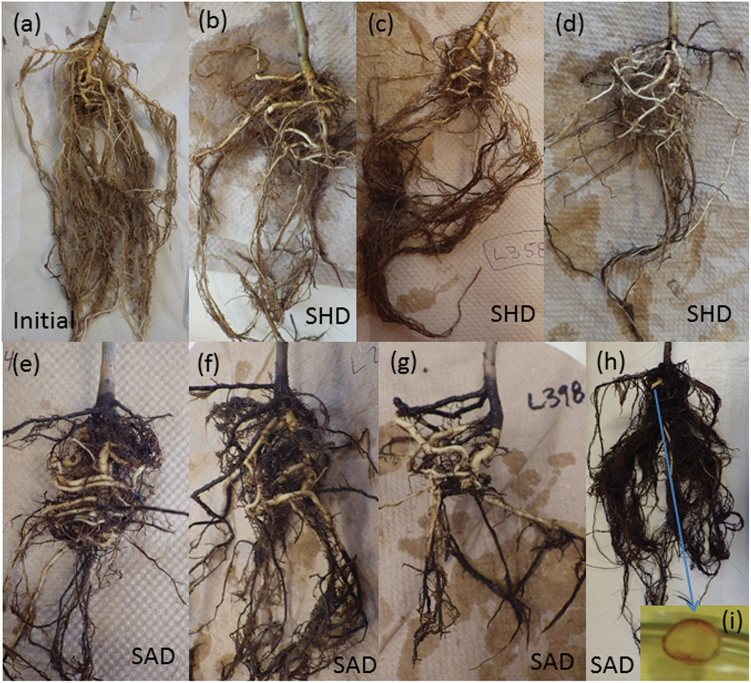
Roots of light-shade seedlings during starvation. (a) A healthy root system at the onset of starvation. (b–d) Root systems at the stem half dead stage (SHD). At this point there appears to be some fine-root death and loss and, in some cases, a small amount of coarse-root death. (e–h) Root systems at the stem all dead stage (SAD). The root condition is variable, but many have a substantial amount of dead major roots and dead or missing fine roots. (i) A cross-section of a white root from (h) was dyed by tetrazolium, thus indicating that this tissue was living.